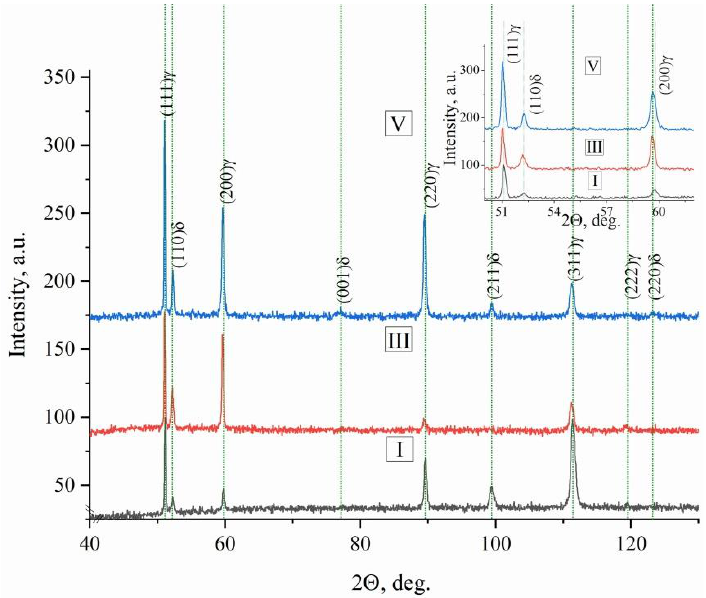
Figure 8. X-ray diffraction of steel areas of bimetallic layered macrocomposite in zones I, III and V. The enlarged image shows X-ray peaks in a section of angles from 52 to 62.